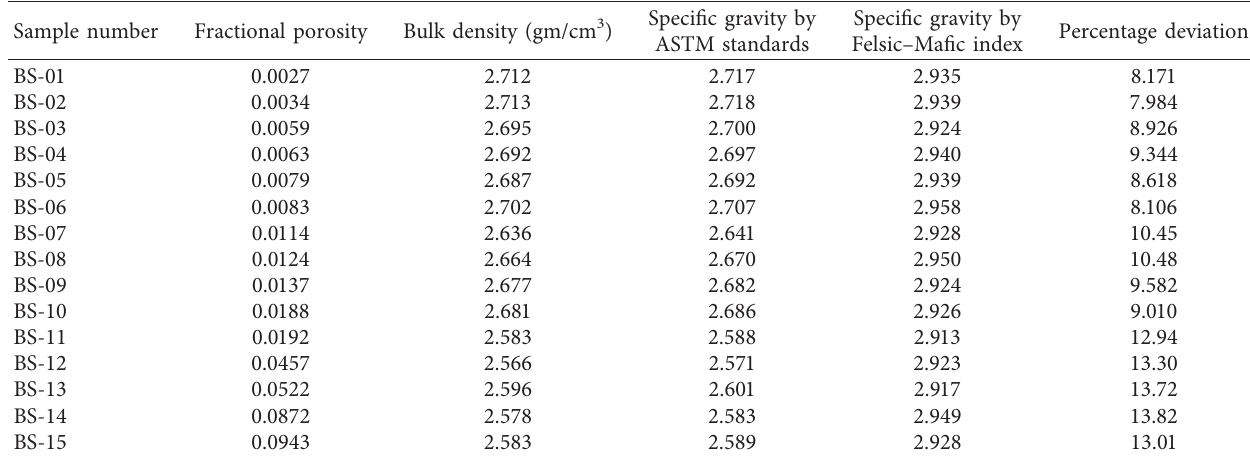
Table 2: Density-related properties of basalt